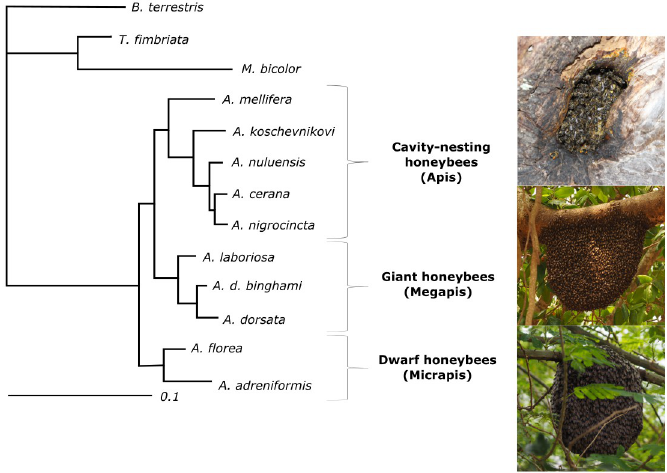
Fig 1. Apis phylogeny. Bayesian consensus tree, graph modified according to Raffiudin and Crozier [15]. Species of the genus Apis can be divided into cavity-nesting bees, giant honey bees and dwarf honey bees. They respectively nest in caves or have open nests, where the colony is either attached to the bottom of the substrate or surrounds the branch they are attached to. Bayesian consensus tree was derived from the data set omitting the third codon position of the cox2 sequence. The credibility values shown were derived from 2000 trees after burnin. Trigona fimbriata , Melipona bicolor and Bombus terrestris are included as